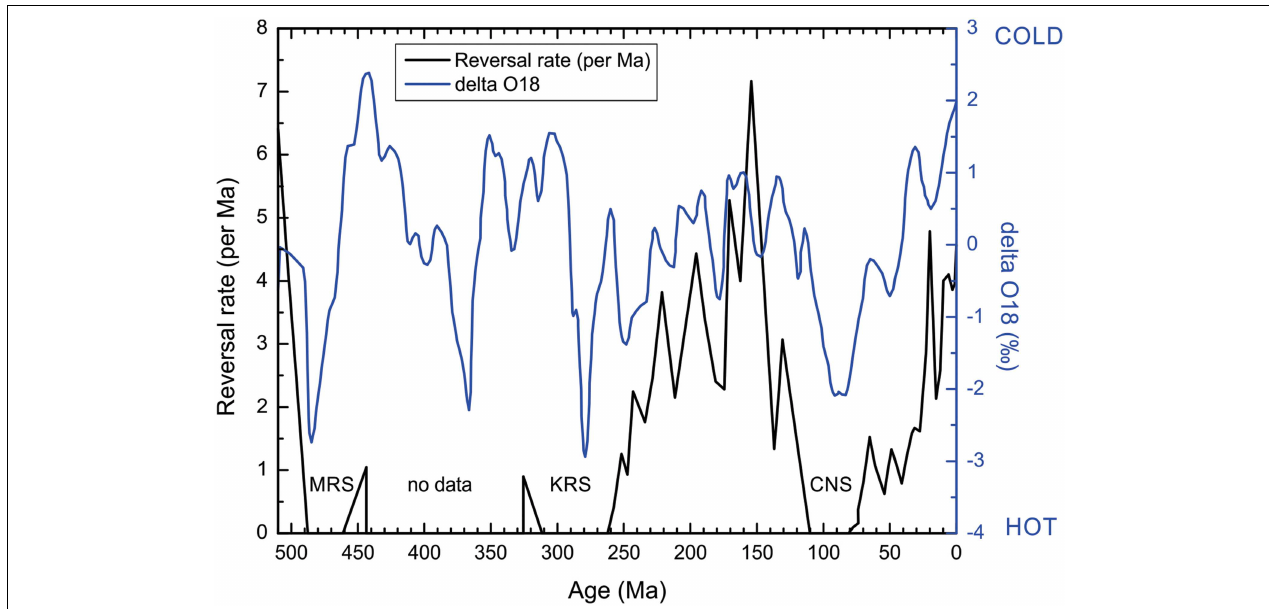
FIGURE 2 | Geomagnetic field reversal rates over the past 510 Myr from Pavlov and Gallet (2005) compared with the δ 18 O (delta O18) variations from Veizer et al. (2000) and Price et al. (2013).